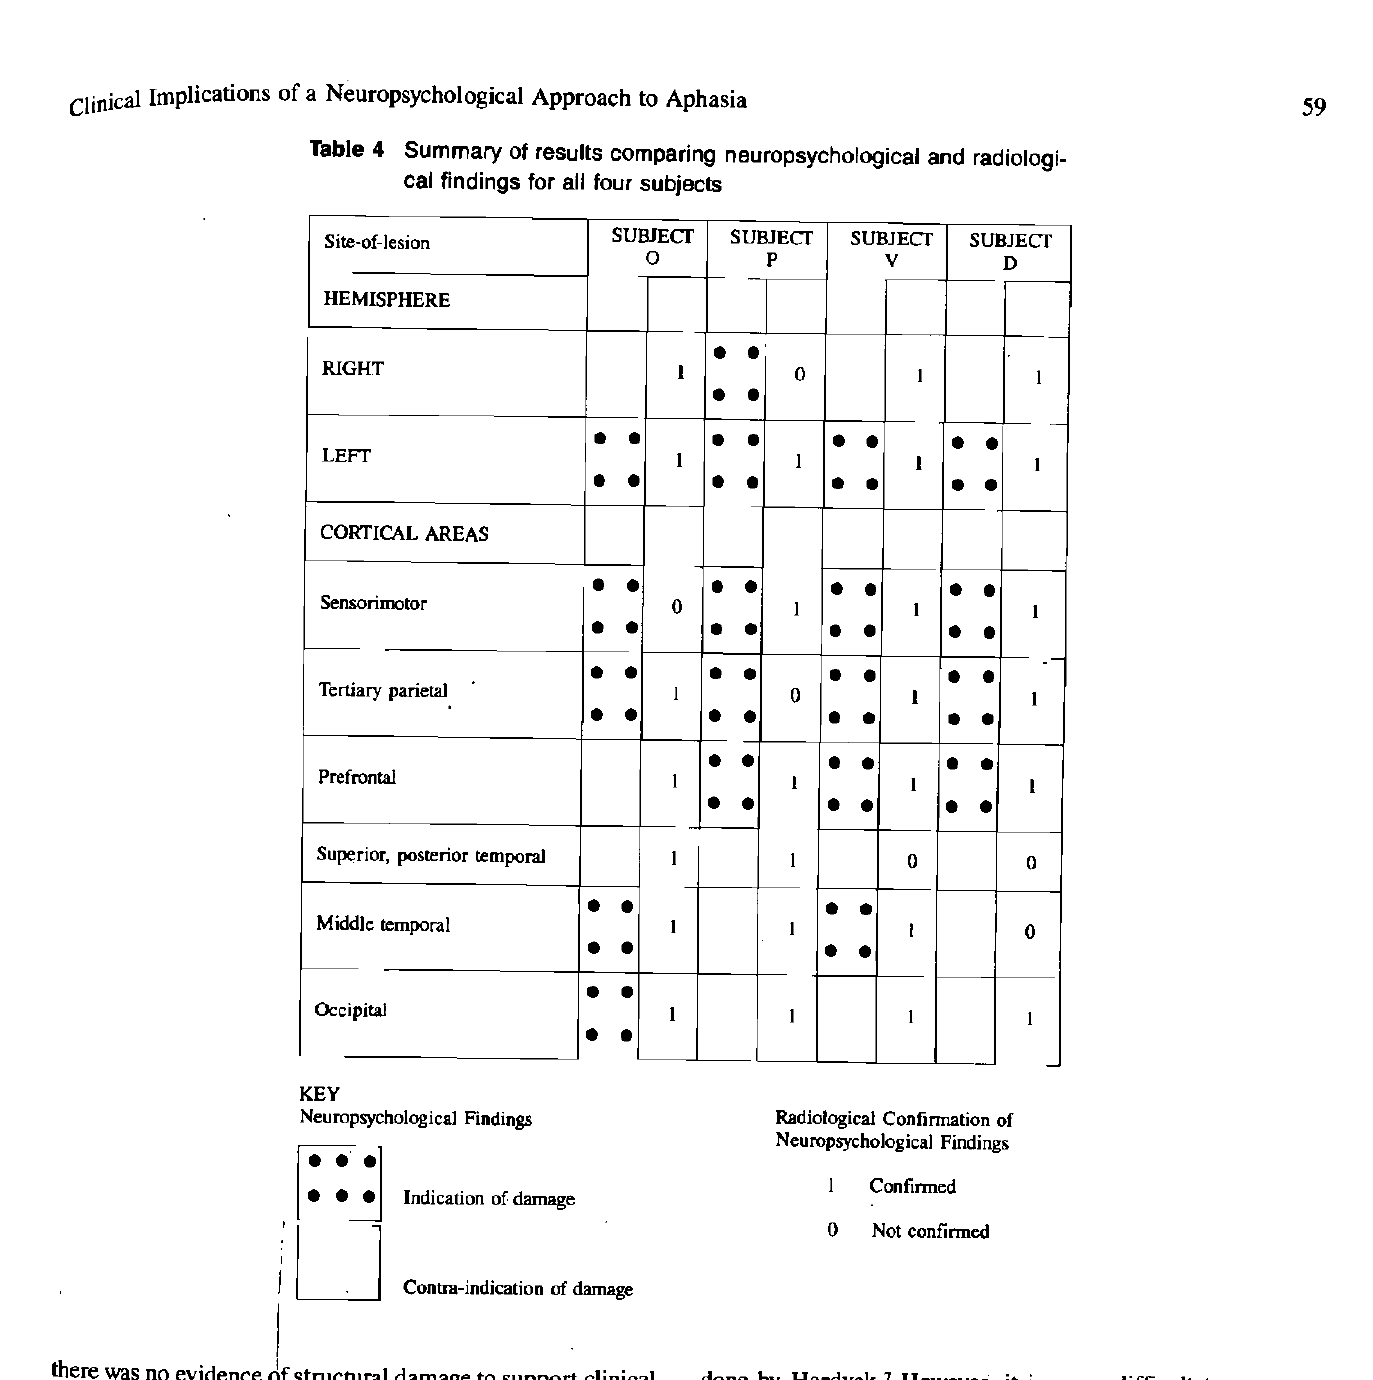
Table 4 Summary of results comparing neuropsychological and